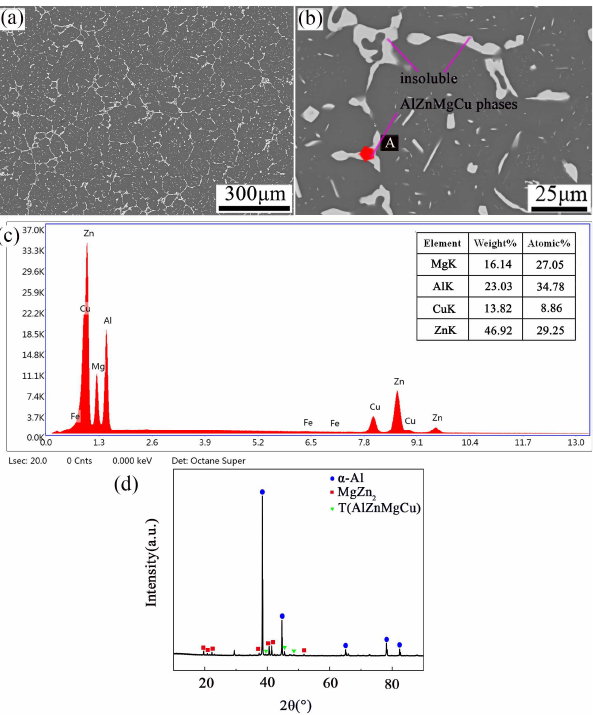
Figure 2. Initial microstructure of Al–10.0Zn–3.0Mg–2.8Cu alloy. ( a ) overall microstructure ( b ) coarse phase ( c ) EDS result of point A ( d ) XRD result.